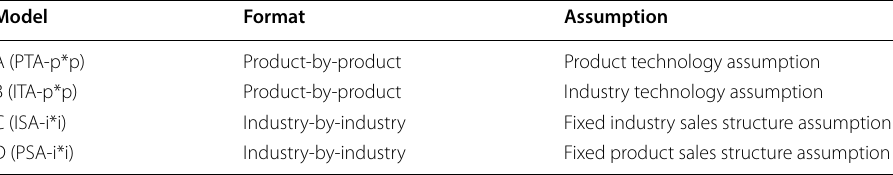
Table 1 Basic modeling principles to derive an IOT from a SUT. Source : Eurostat (2008, p. 296) Model Format Assumption